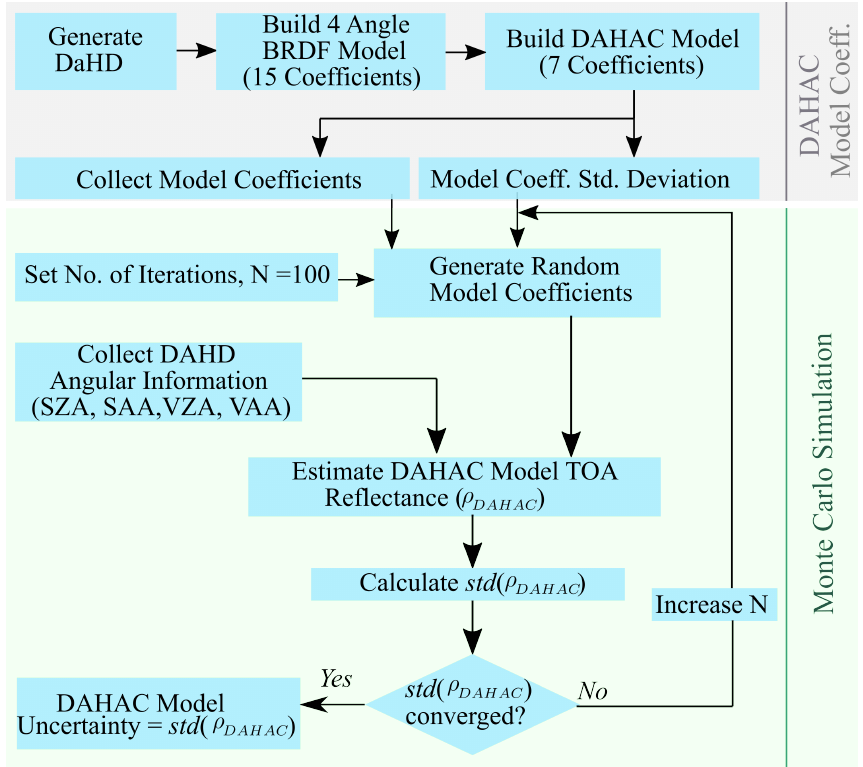
Figure 24. Flowchart showing the calculation of DAHAC model’s